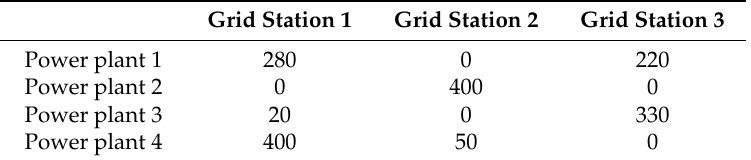
Table 8. Optimal transmission quantities from generation plants to grid stations (MW).